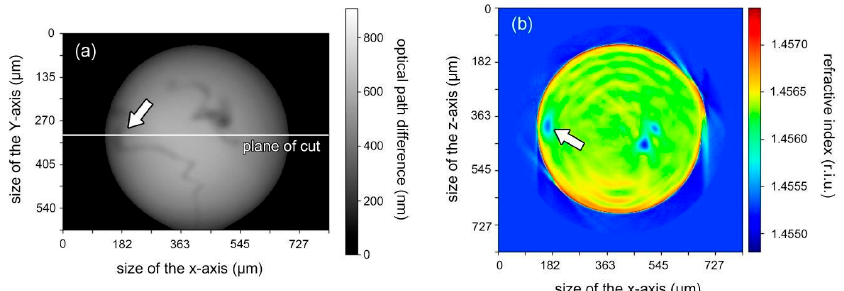
Figure 2. The results of the microcavity local inhomogeneities study made by optical tomography [52]: ( a ) Phase image of a microcavity, side view; ( b ) Two-dimensional tomogram slice of a microcavity in the equator area. The color shows the spatial distribution of the refractive index. The arrow indicates the local region where the defect is located, which appeared as a result of the optical fiber core melting.